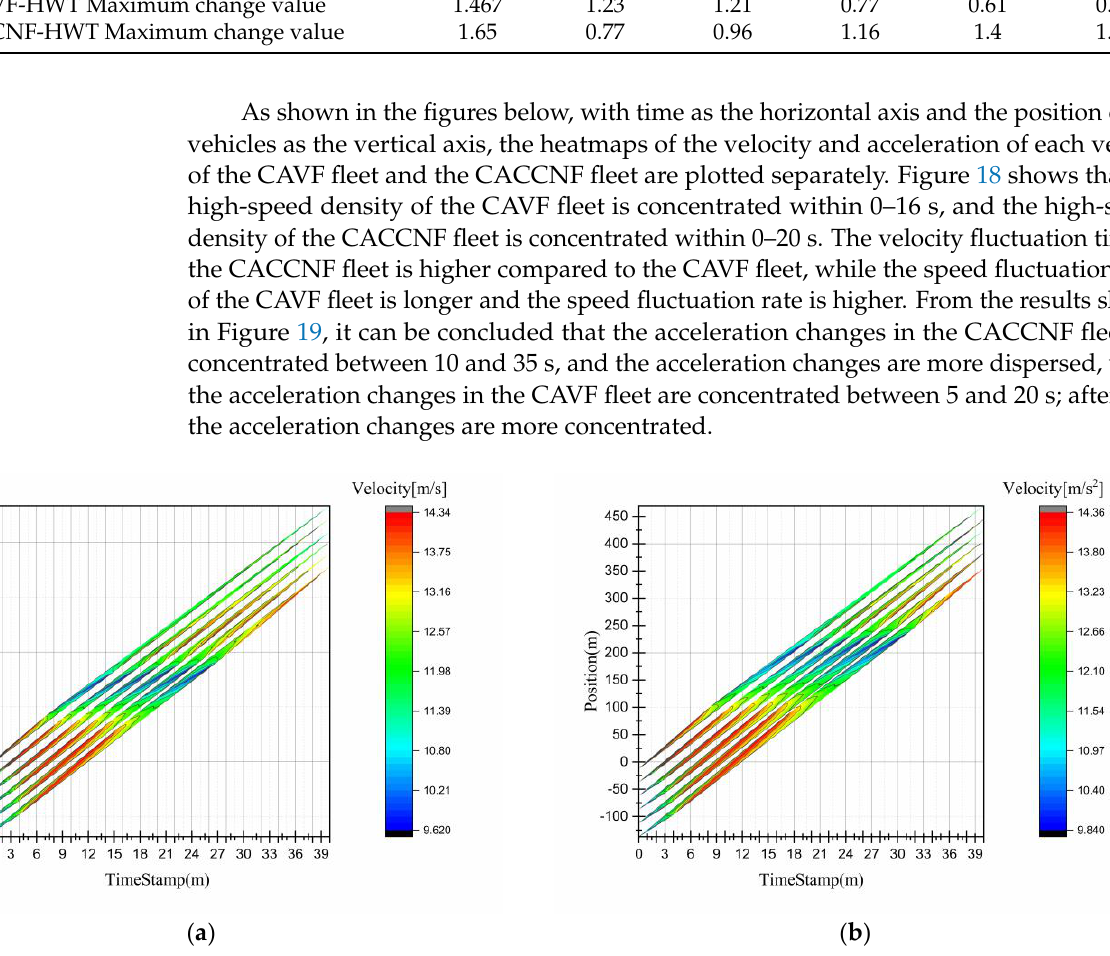
Figure 18. Velocity heatmaps of CAVF fleet and CACCNF fleet under scenario 4: ( a ) CAVF velocity heatmap; ( b ) CACCNF velocity heatmap.